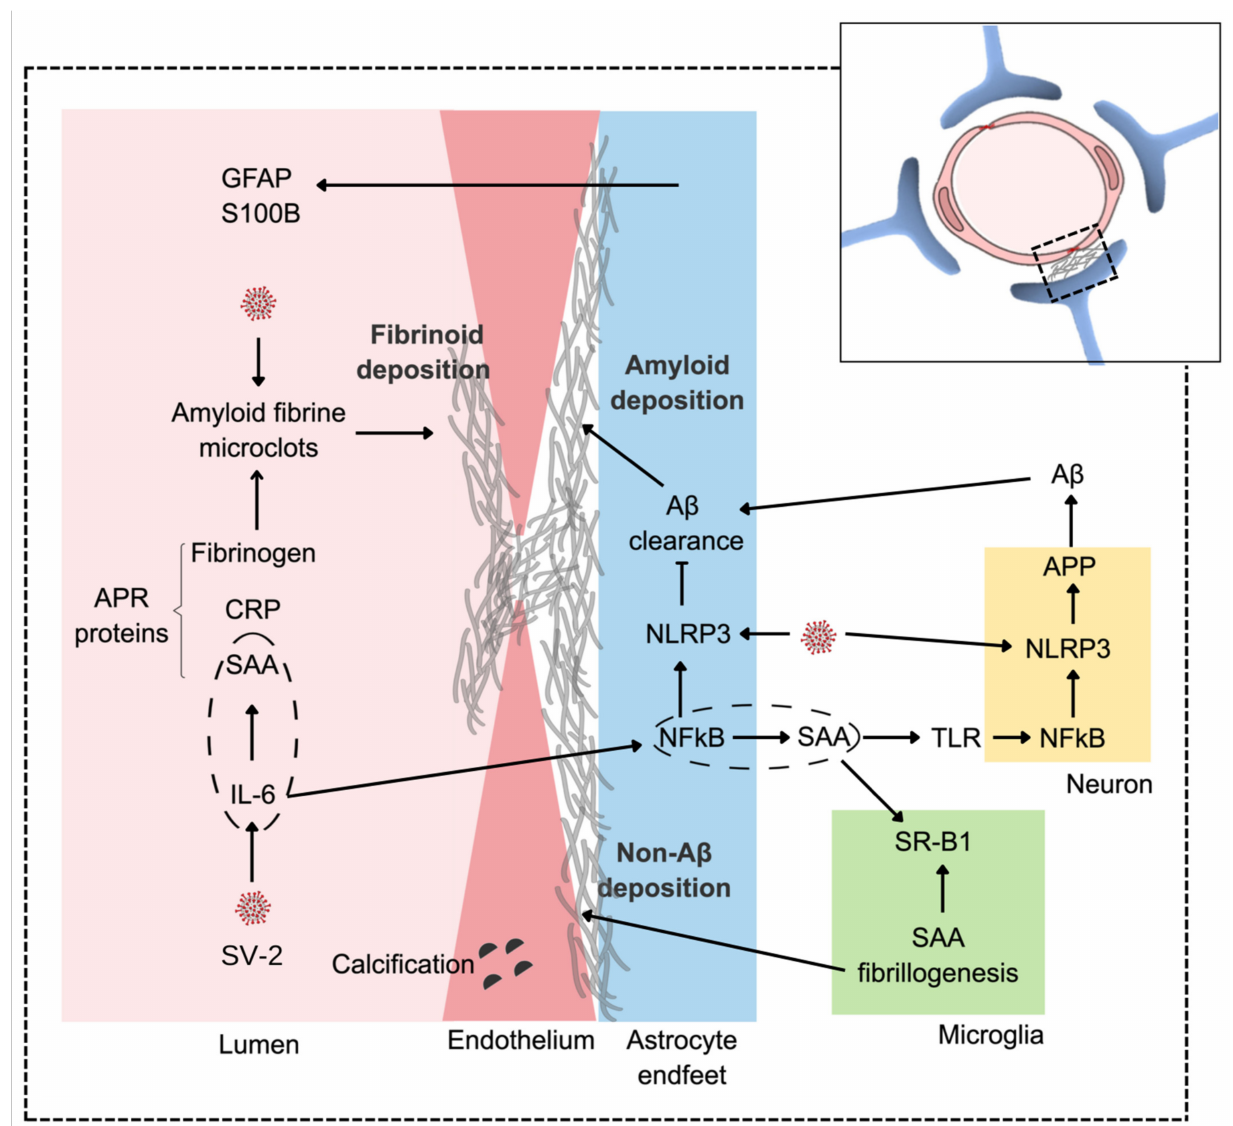
Figure 2. An integrative view of amyloid vascular deposition. SARS-CoV-2 (SV-2) triggers a pe- ripheral hypercytokinemia led by IL-6, which, in the liver, leads to exacerbated production of APR proteins, including C-reactive protein, SAA, and fibrinogen. In the CNS, the virus directly affects endothelial cells and astrocytes compromising the BBB by inducing and facilitating vascular fibrinoid deposition. The astroglial response to SARS-CoV-2 and/or hypercytokinemia may be accompanied by increases in serum GFAP and S100B. The virus (via NLRP3) also increases APP metabolism, generating more A β . With astroglial dysfunction (also involving NLRP3), there is a reduction in A β clearance, leading to perivascular amyloid deposition. Note that IL-6, centrally, leads to an increase in astroglial SAA, which, in turn, could amplify APP neuronal processing through the activation of the TLR/NF-KB/NLRP3 pathway. Dashed ellipses emphasize the production of SAA by IL-6 in the hepatocytes (not shown) and astrocytes. Elevated peripheral production of SAA can accentuate fibrinoid deposition, while astroglial production can lead to non-AB amyloid deposition, which, in the CNS, involves the microglial scavenger receptor B1